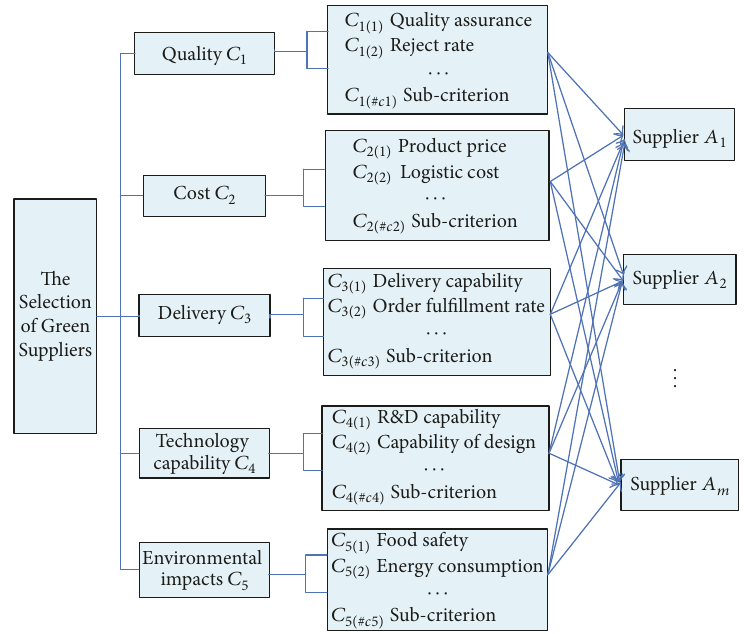
Figure 3: The assessed framework of green suppliers in food supply